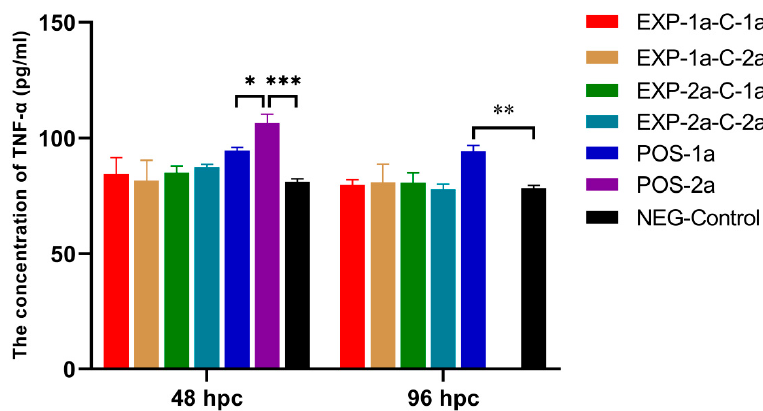
Figure 8. Levels of the cytokine Tumor necrosis factor- α (TNF- α ) in all piglets at 48 and 96 hpc. The mortality of POS-2a was more than 40% in 96 hpc, the levels TNF- α were not detected; * indicates p < 0.05, ** indicates 0.001 < p ≤ 0.01, and *** indicates p ≤ 0.001.